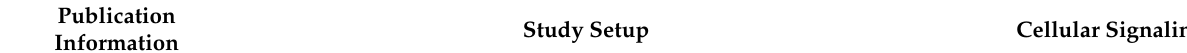
Table 7. In vitro results related to PFAS exposures and cellular signaling